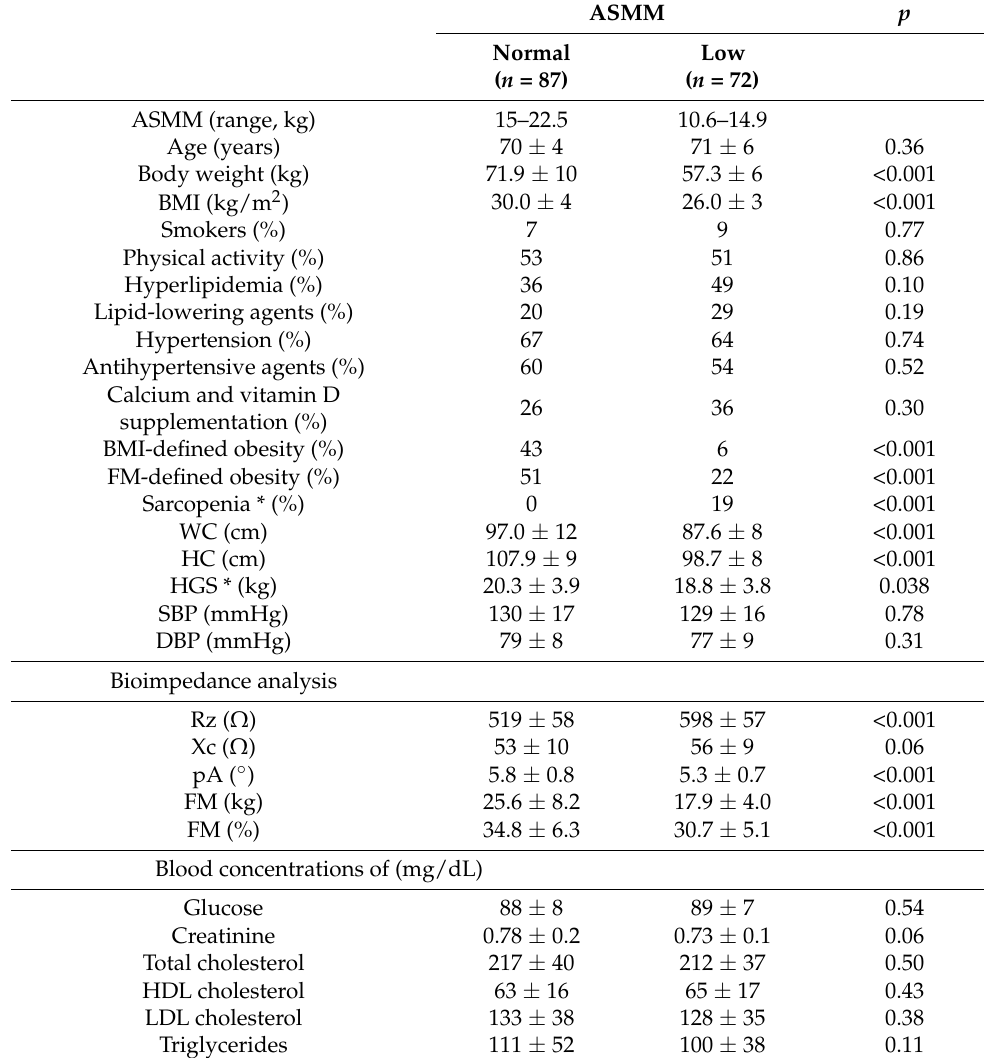
Table 2. Characteristics of the cohort that was classified according to appendicular skeletal mus- cle